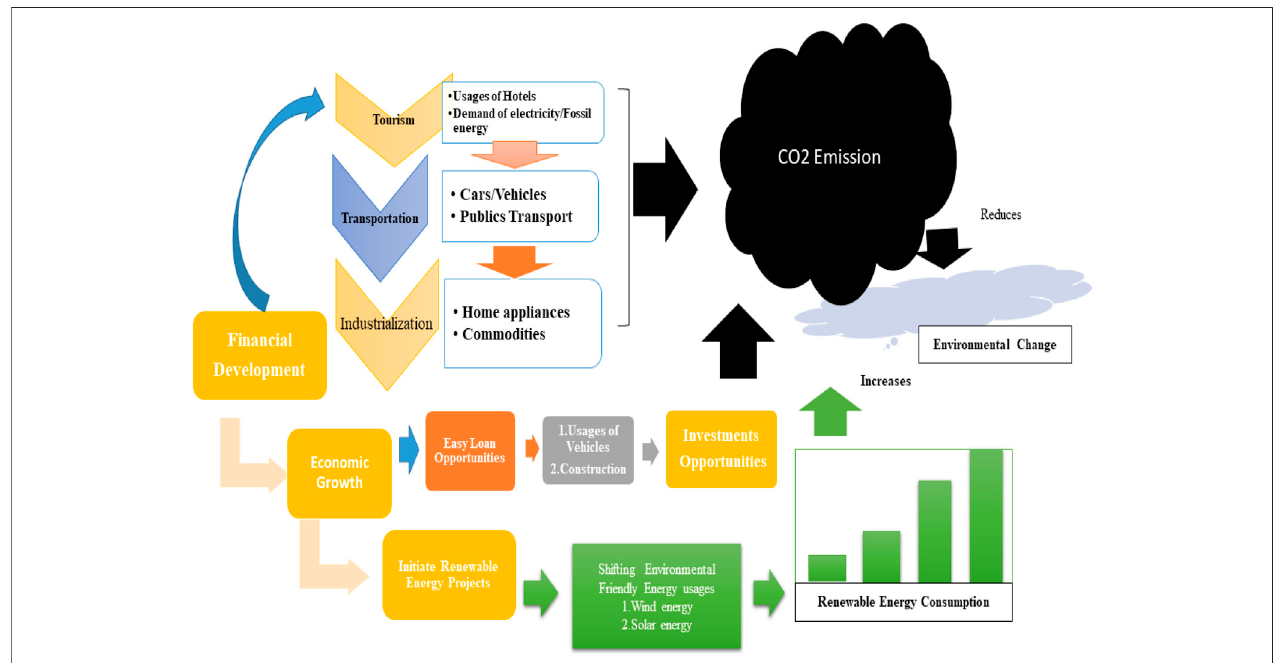
FIGURE 1 | Conceptualization of the anticipated